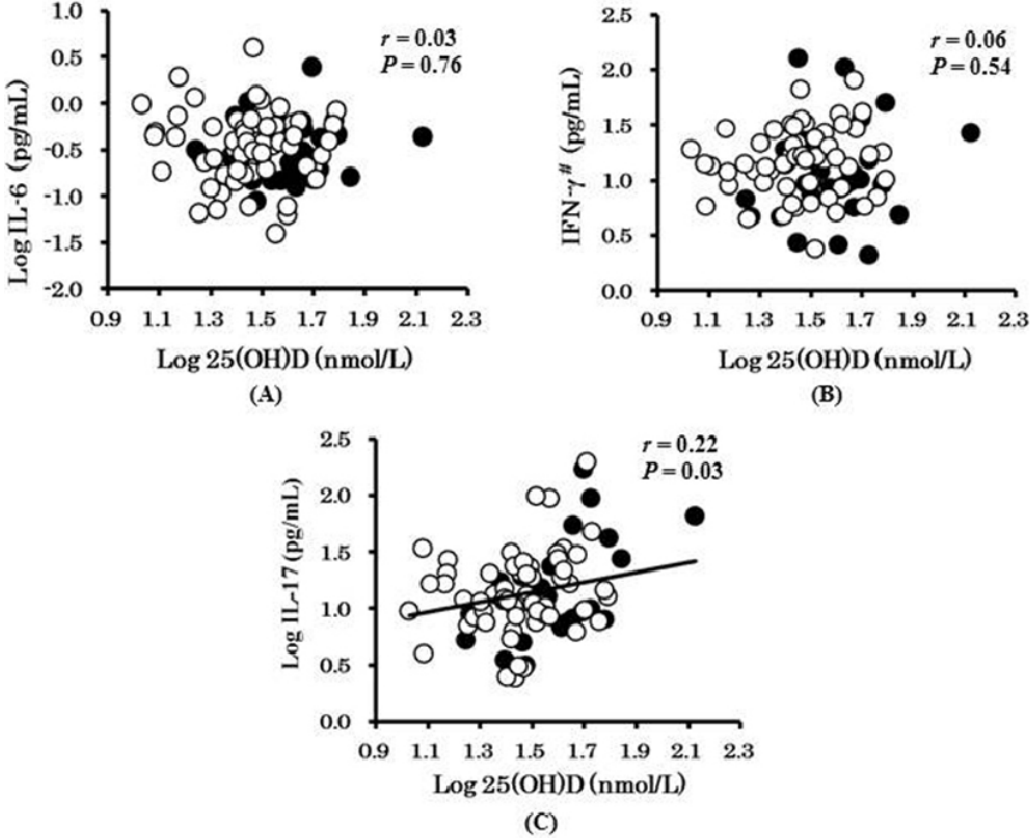
# reciprocal-of-square-root transformed before performing the analysis. Open and closed circles represent data from women and men,